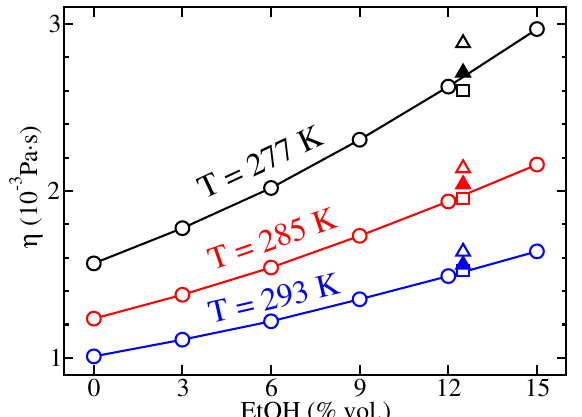
Figure 2. Experimental viscosities of hydroalcoholic solutions at T = 277 K (black circles), T = 285 K (red circles), and T = 293 K (blue circles). Viscosities from the literature obtained for hydroalcoholic solutions (open squares) and brut-labeled champagnes (triangles) are also indicated [33]. Data on brut-labeled champagnes are derived from viscometry (open triangles) and an Arrhenius law (closed triangles)